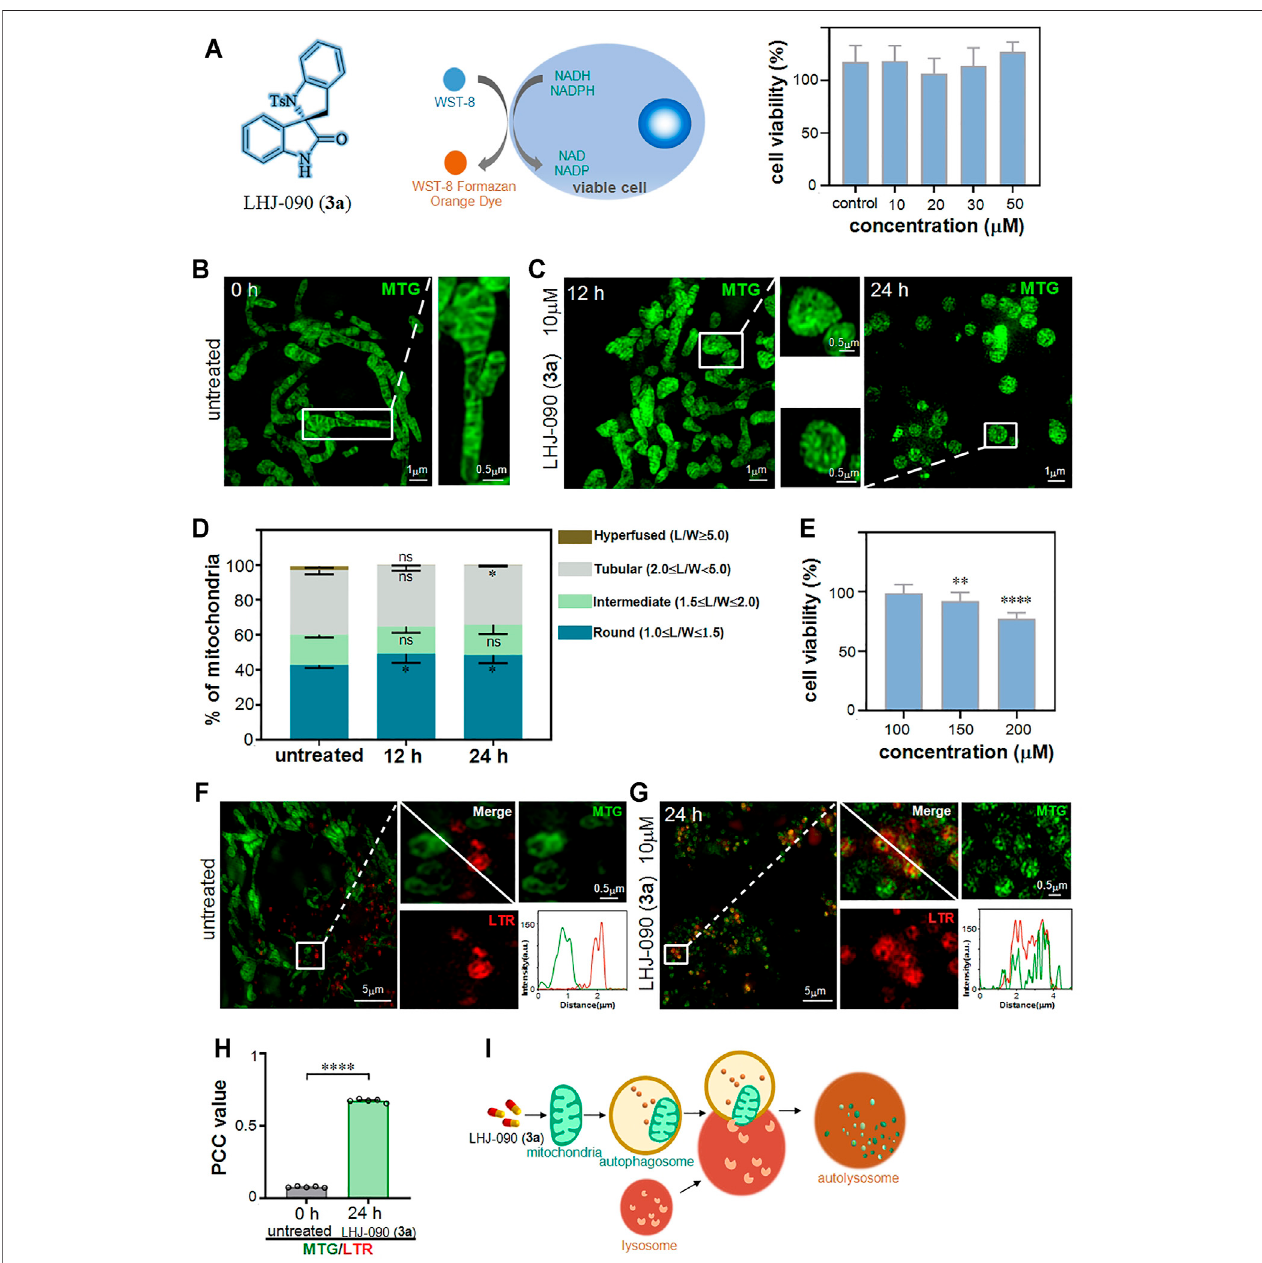
FIGURE 2 | LHJ-090 ( 3a ) damage mitochondria and stimulate the process of mitophagy. (A) The cell viability (%) obtained with cck8 assay. Percentage of viable HeLacellsaftertreatedwithdifferentconcentrationsof 3a (010,20,30and50 μ M)for24 h (B,C) SIMimagingofmitochondriainHeLacellsweretreatedwith 3a (10 μ M) for 0, 12, and 24 h and then stained with the mitochondrial tracker probe (mito-tracker-green, MTG) ( λ ex (cid:1) 488 nm) for 0.5 h. (D) Quantitative analyze of mitochondrial morphology inHeLacells after treated with 3a for0, 12,and 24 h. DatawasappearedasMean ± SEM( n (cid:1) 5). * p < 0.05, all compared with untreated cells. (E) The cell viability (%) obtained with CCK-8 assay at high concentration 3a stimulation, more than 150 μ M shows toxicity to cells. (F,G) SIM colocalization images of MTG- stained mitochondria and LTR-stained lysosome with (G) or without (F) 3a treatment, the white solid square indicates fl uorescence intensity. (H) The PCC values for MTG and LTR in HeLa cells from (F) and (G) . (I) A schematic diagram of the role of 3a in mitochondrial damage.